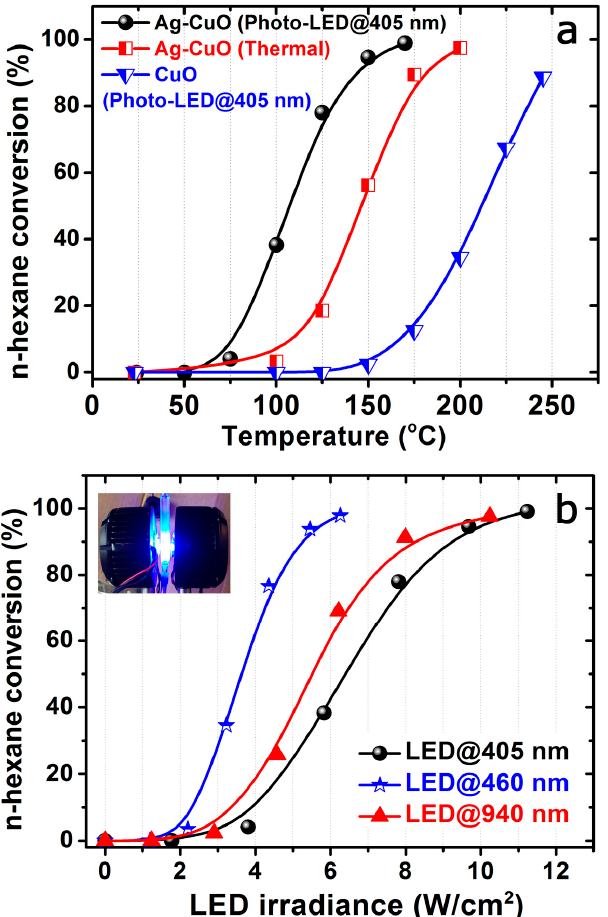
Figure 3. LED-driven photocatalytic oxidation of n-hexane: ( a ) n-hexane conversion curves obtained after photocatalytic activation of Ag-CuO (spherical symbols), CuO (triangle symbols) with a LED emitting at 405 nm, and alternatively after thermal heating of Ag-CuO with a conventional heating setup (square symbols); ( b ) n-hexane light-off curves under different irradiation wavelengths as a function of the irradiance (in W/cm 2 ) specifically required for each LED; (inset: Digital image of the 405 nm LEDs simultaneously irradiating the quartz cuvette reactor).